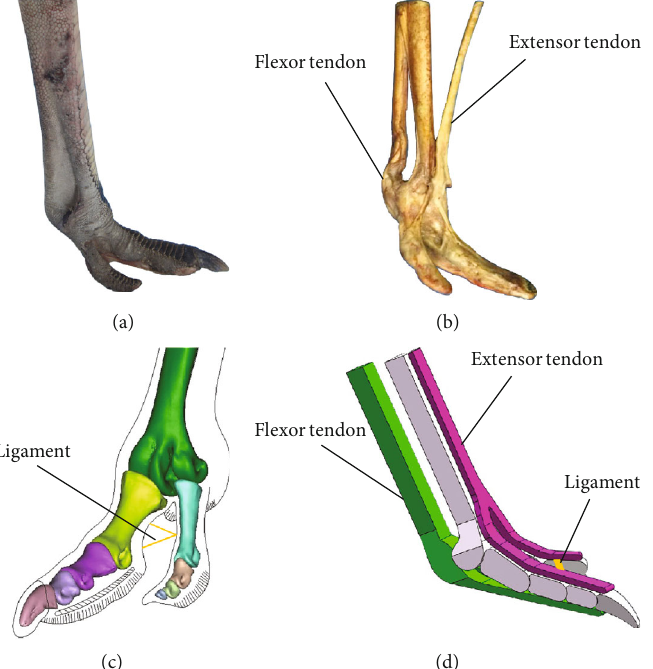
Figure 1: Ostrich foot specimen and 3D model. (a) Ostrich foot specimen. (b) Dissected ostrich foot. (c) 3D model of ostrich foot. (d) 3D simpli fi ed model of ostrich